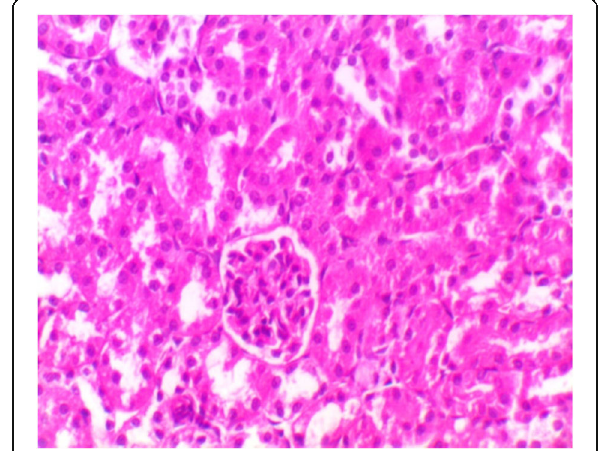
Fig. 19 Photomicrograph of treated sections of kidney with (CCL4 + NAC) showing improvement in architecture of sections (H&E; × 400)